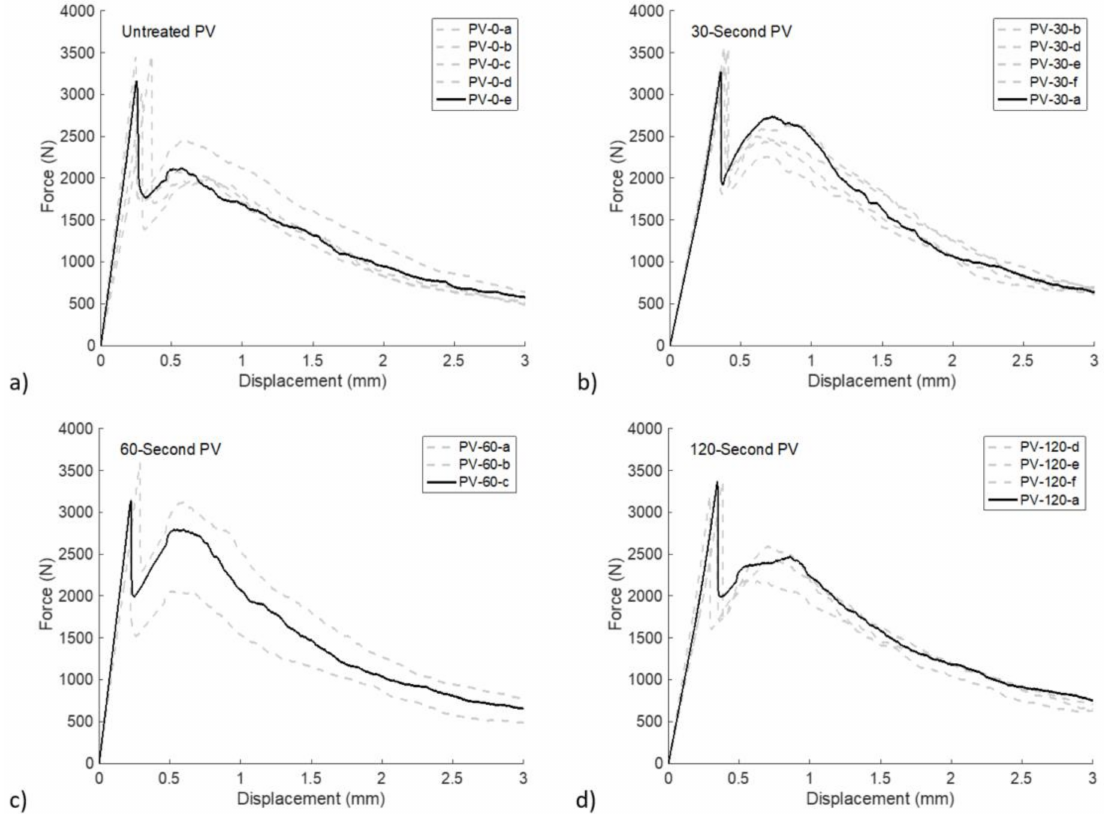
Figure A4. Force-displacement curves for all PV specimens tested in flexure at ( a ) 0 s of treatment time, ( b ) 30 s of treatment time, ( c ) 60 s of treatment time, and ( d ) 120 s of treatment